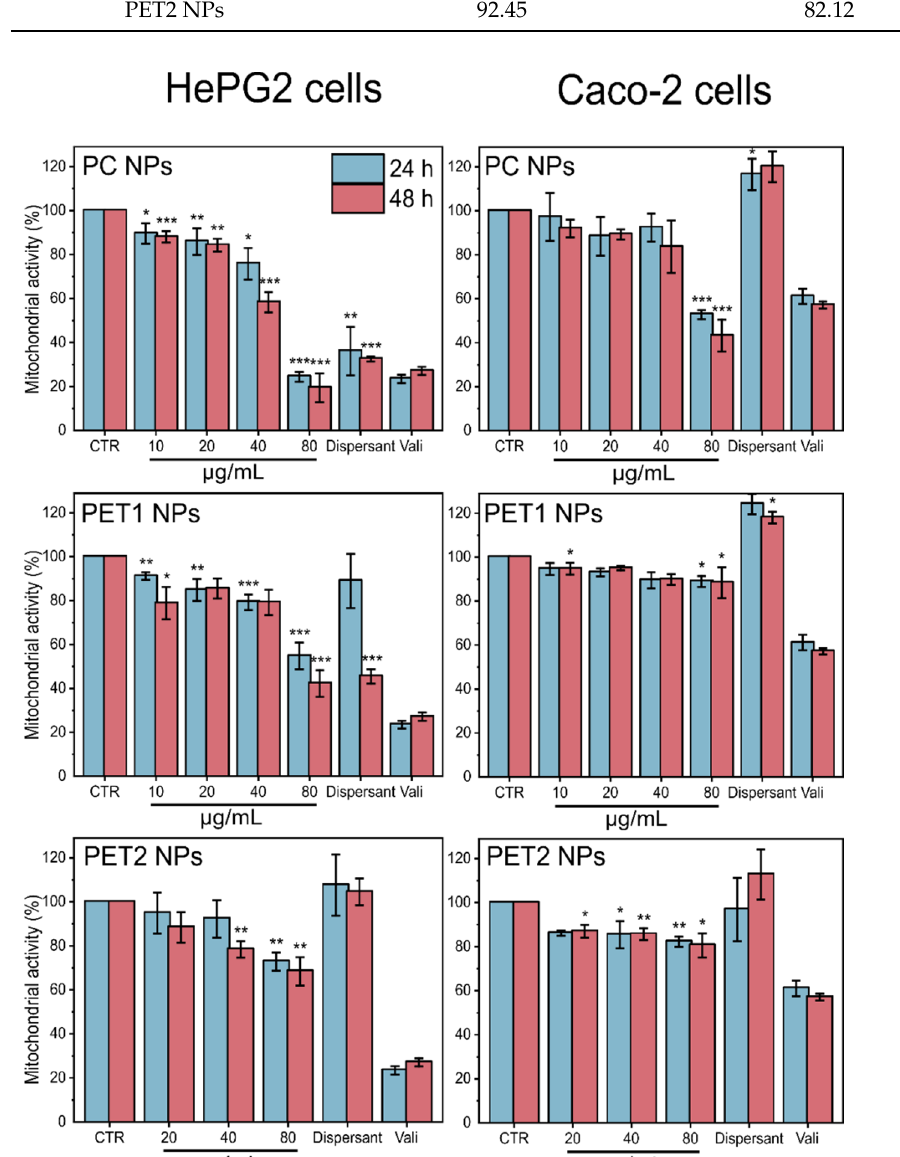
Figure 5. Mitochondrial activity of HePG2 and Caco-2 cells exposed to different concentrations of PC or PET NPs for 24 or 48 h, measured by HCS. Results are expressed as percentage of mitochondrial activity compared to the untreated cells. Valinomycin (900 nM) was used as positive control. Data are reported as the average of three independent experiments (each run in technical triplicate) ± SD. p < 0.001, p < 0.01 and p < 0.05 are reported (***, ** and * respectively), calculated versus CTRL (one-way ANOVA).